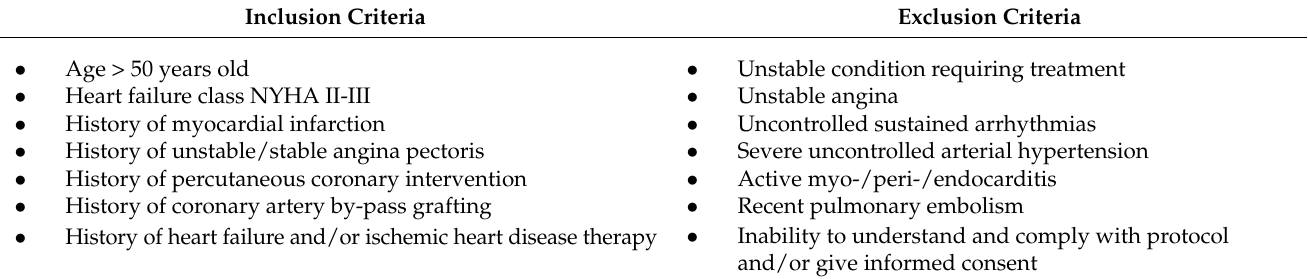
Table 1. Inclusion and exclusion